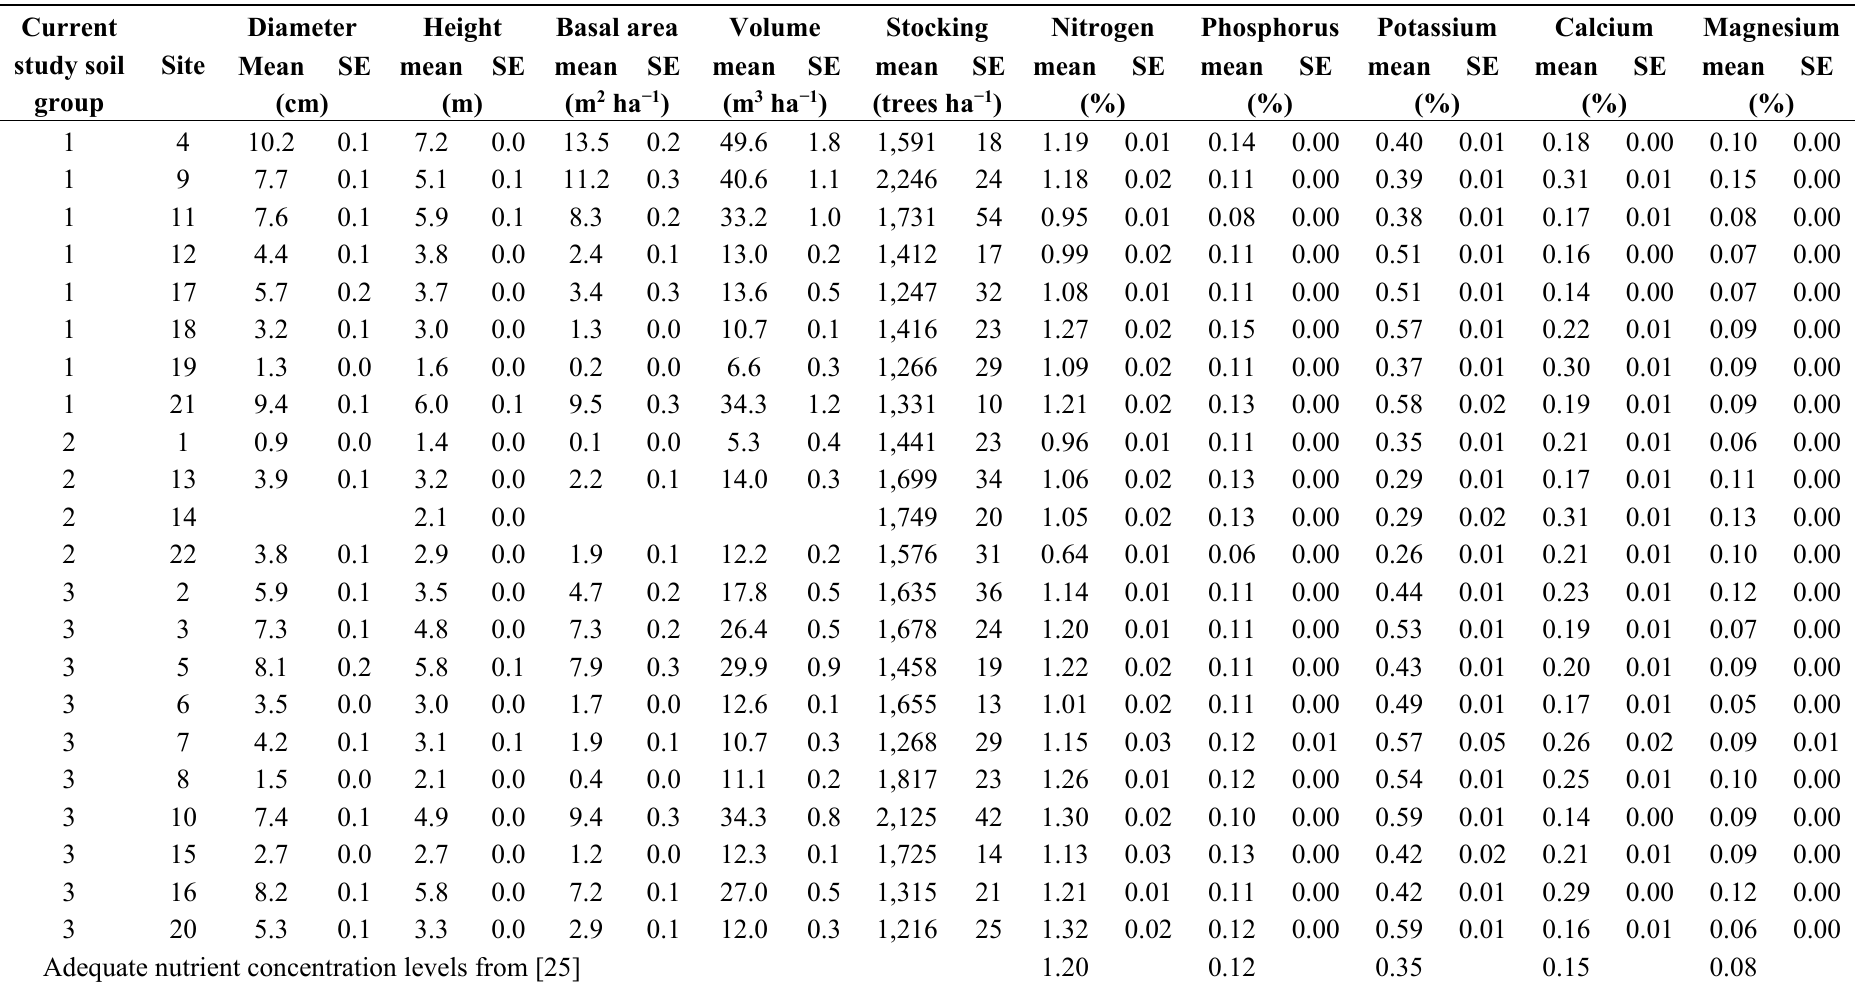
Table 3. Tree and stand measurements (diameter at breast height, height, basal area, volume and stocking) and foliar nutrient concentration (nitrogen, phosphorus, potassium, calcium, and magnesium) mean and standard deviation (SE) prior to treatment initiation for the 22 sites where fertilizers were applied in varying doses and frequencies. Diameter at breast height was not measured at Site 14 prior to treatment